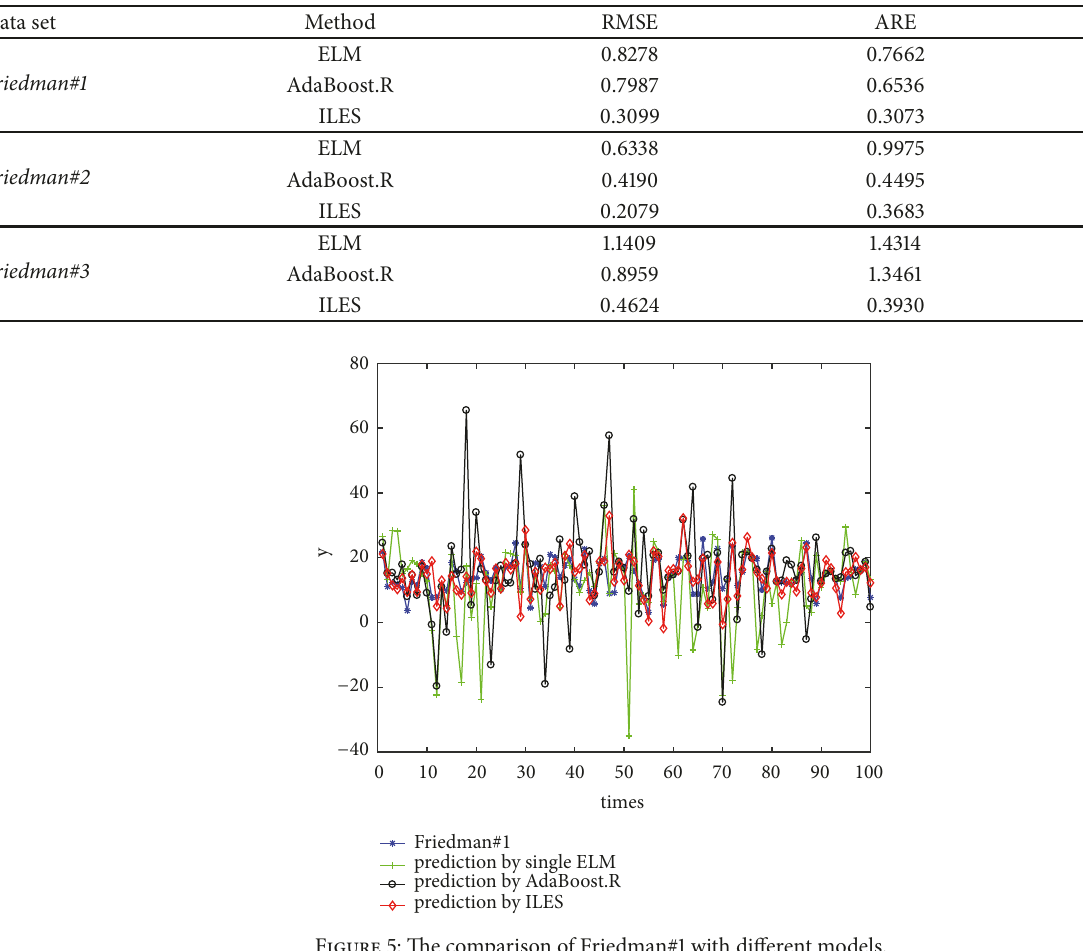
Table 6: The performance comparisons of the algorithms.